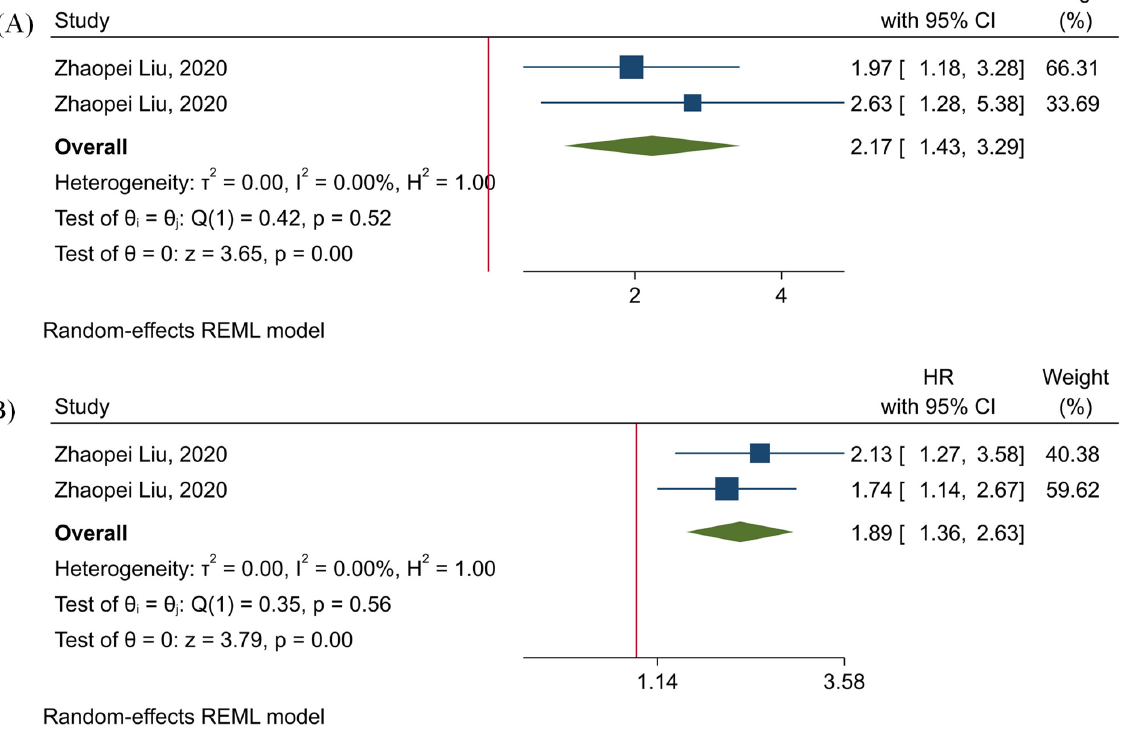
Figure 5. Forest plots for assessing the prognostic value of tumor-infiltrating TIGIT + CD8 + T-cells. ( A ) OS, and ( B ) RFS.